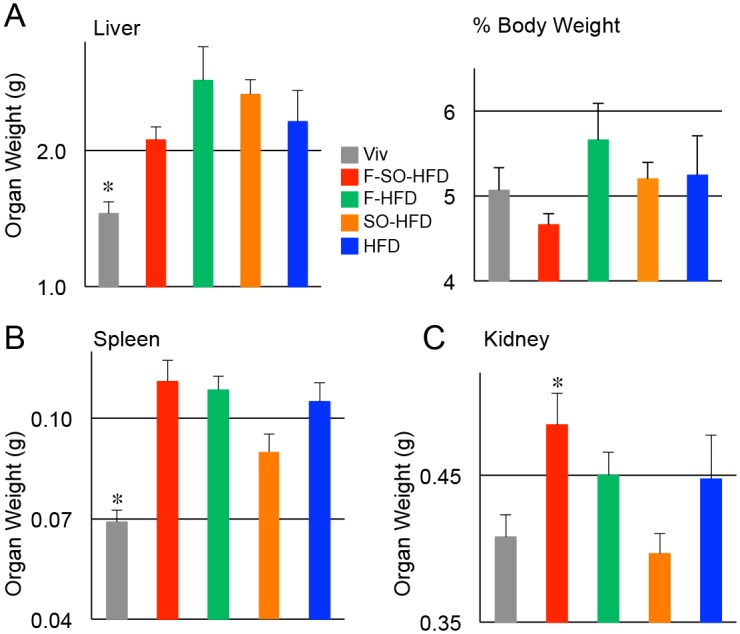
Fructose enhances liver/body weight ratio and kidney weight; soybean oil is protective in spleen and kidney.Average weight of organs harvested from C57/BL6 mice on the indicated diets as in Fig 1 for 35 weeks. A) Left, total liver weight. * Significantly lower than SO-HFD and F-HFD. Right, liver as percent of body weight. B) Spleen weights. * Significantly lower than all others except SO-HFD; C) Kidney weights (both combined). * Significantly higher than Viv and SO-HFD;. N = 6–12 per diet. Significance is defined as P ≤ 0.05 by ANOVA with Tukey’s post-hoc analysis.